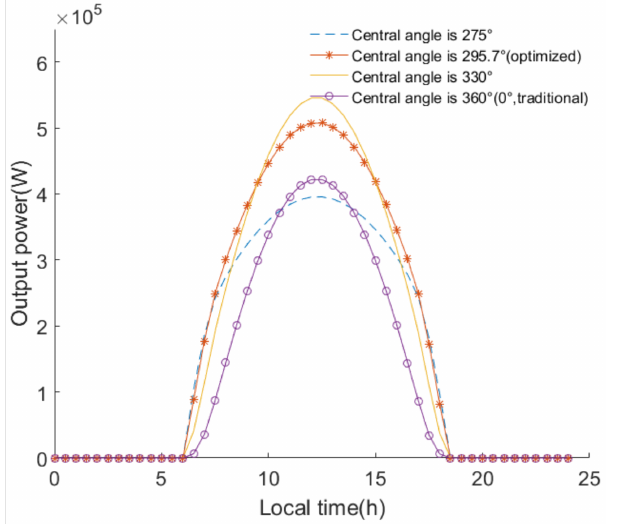
Figure 10. Comparison of instantaneous output power of solar array for different central